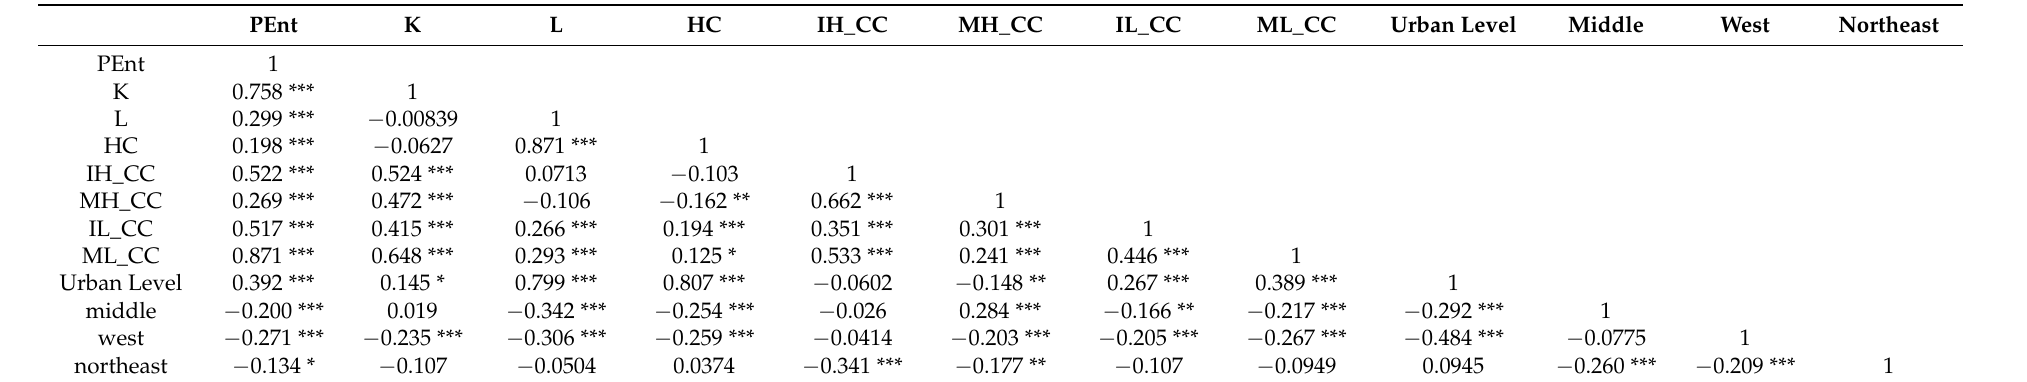
Table 1. Correlations between main